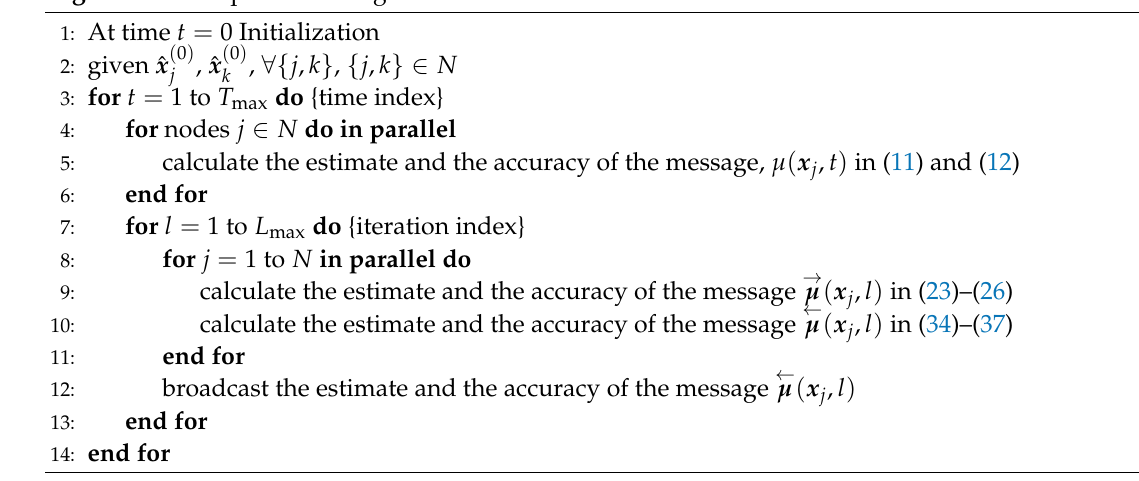
Algorithm 1 Simplified MP